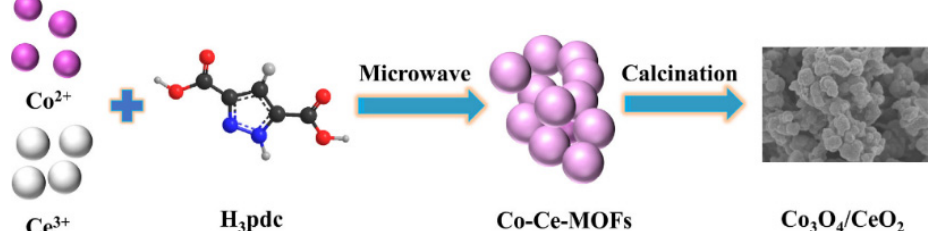
Figure 6. Schematic illustration of Co 3 O 4 /CeO 2 preparation. Reproduced with permission from Ying Kang, Highly efficient Co 3 O 4 /CeO 2 heterostructure as anode for lithium-ion batteries; published by Elsevier, 2020 [11].